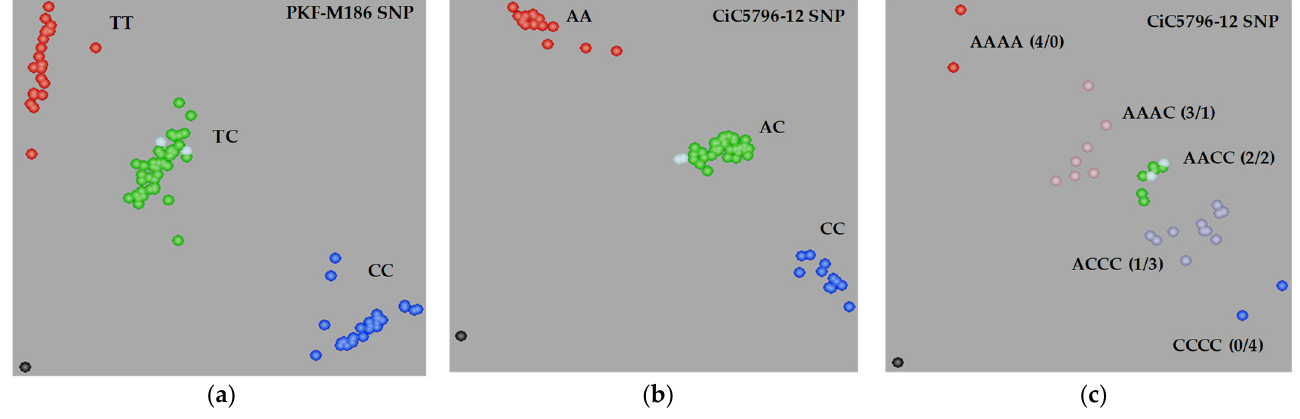
Figure 4. ( a ) Plot of the T and C allele signals of the PKF-M186 SNP marker from the cluster analysis of 80 diploid hybrids recovered by the self-pollination of the ‘Fortune’ mandarin by bud pollination. Diploid homozygous (TT and CC) and heterozygous hybrids (TC) originated from the heterozygous ‘Fortune’ mandarin indicated by white spots. ( b ) Plot of the A and C allele signals of the CiC5796-12 SNP marker from the cluster analysis of 61 diploid hybrids recovered by the self-pollination of the diploid ‘Clemenules’ clementine by bud pollination. Diploid homozygous (AA and CC) and heterozygous hybrids (AC) originated from the heterozygous 2x clementine indicated by white spots. ( c ) Plot of the A and C allele signals of the CiC5796-12 SNP marker from the cluster analysis of 29 4x hybrids recovered by the self-pollination of 4x ‘Clemenules’ clementine. Tetraploid homozygous (AAAA and CCCC, with 4/0 and 0/4 allele dosage, respectively) and tetraploid heterozygous hybrids (AAAC, AACC and ACCC with 3/1, 2/2 and 1/3 allele dosage, respectively) originated from heterozygous 4x clementine indicated by white spots.